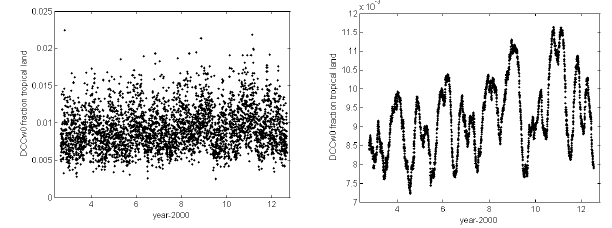
Figure A. The left panel shows the day/night averaged daily faction of tropical land associated with 705 Fig. A1. The left panel shows the day/night averaged daily faction DCCw0. The right panel shows the same data, but smoothed with a 96 day running average. 706 of tropical land associated with DCCw0. The right panel shows the same data, but smoothed with a 96-day running